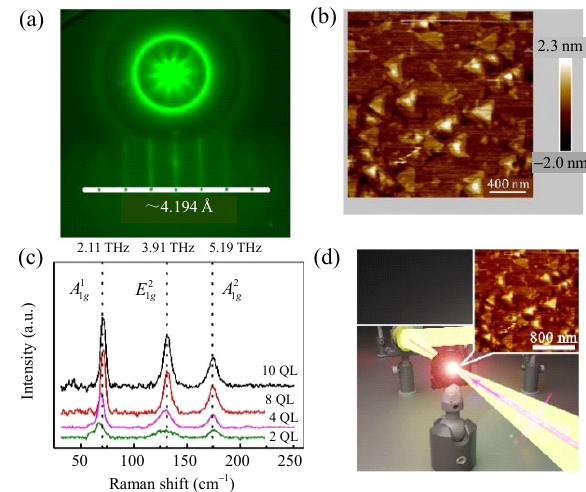
Fig. 1 Characterization of Bi 2 Se 3 films by: (a) RHEED pattern, (b) AFM, (c) Raman spectroscopy, and (d) schematic diagram of photoactive switching of THz wave with the Bi 2 Se 3 sample.